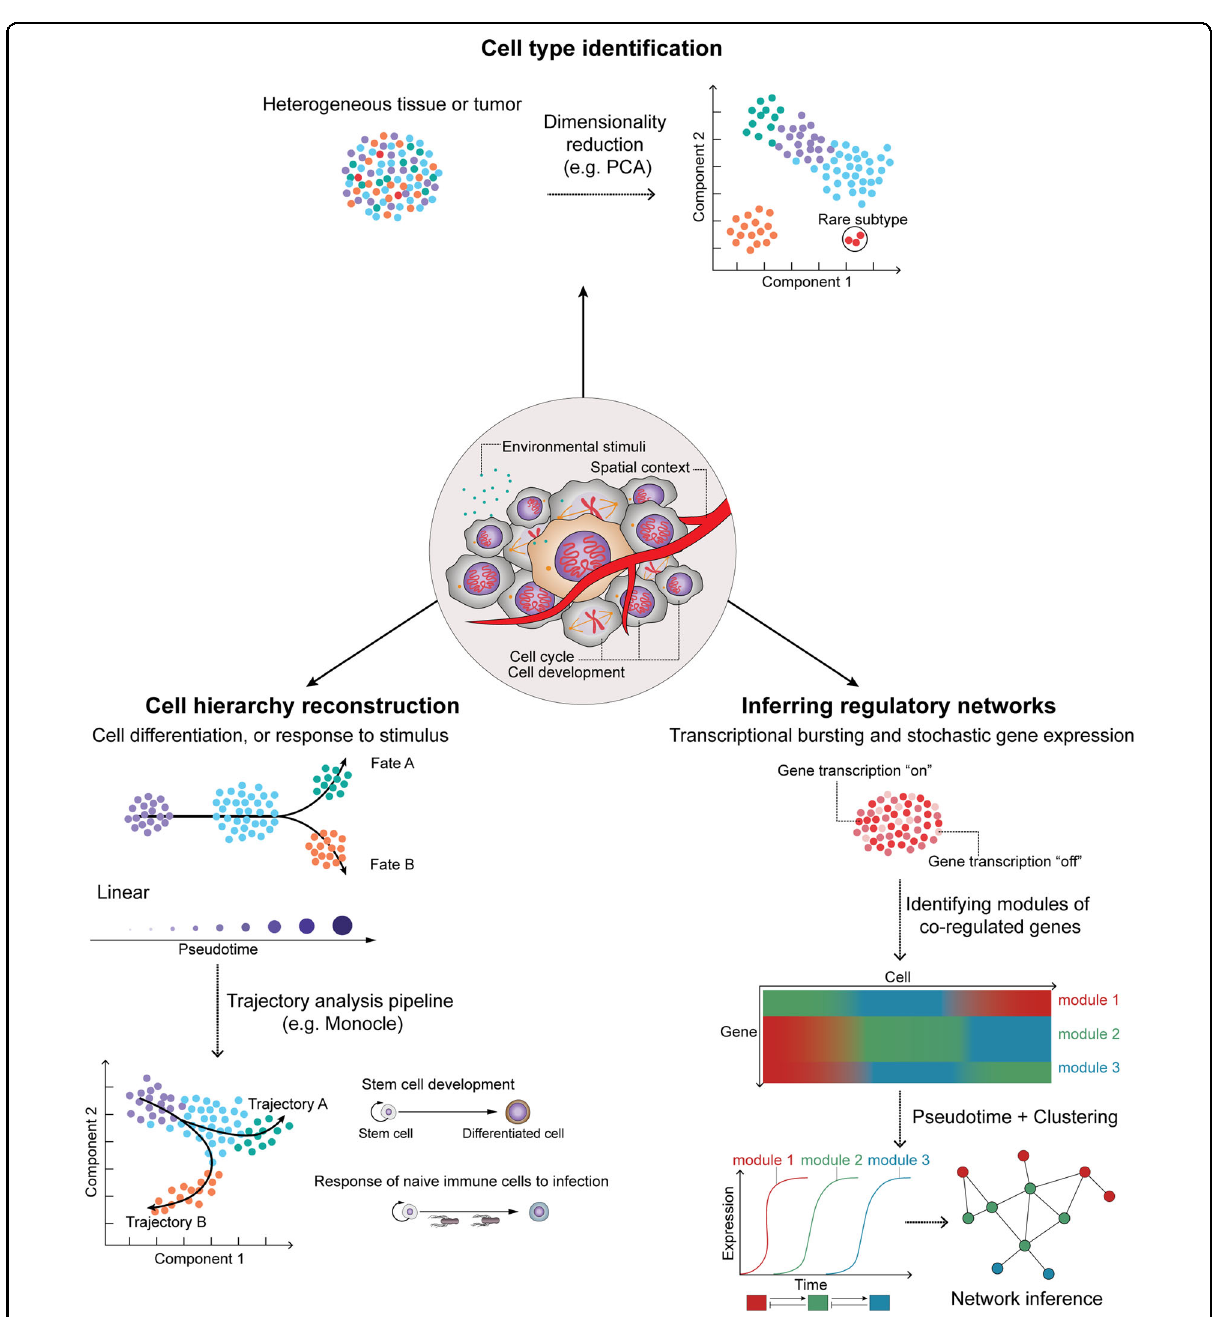
Fig. 5 Applications of scRNA-seq computational approaches. Cells are living in a dynamic context interacting with their surrounding environment. PCA can be used to identify known and unknown cell clusters. Cell hierarchy reconstruction can be performed after 2D projection of normalized gene expression pro fi les. Decoding the regulatory network integrates pseudotime-inferred trajectories and clustering gene